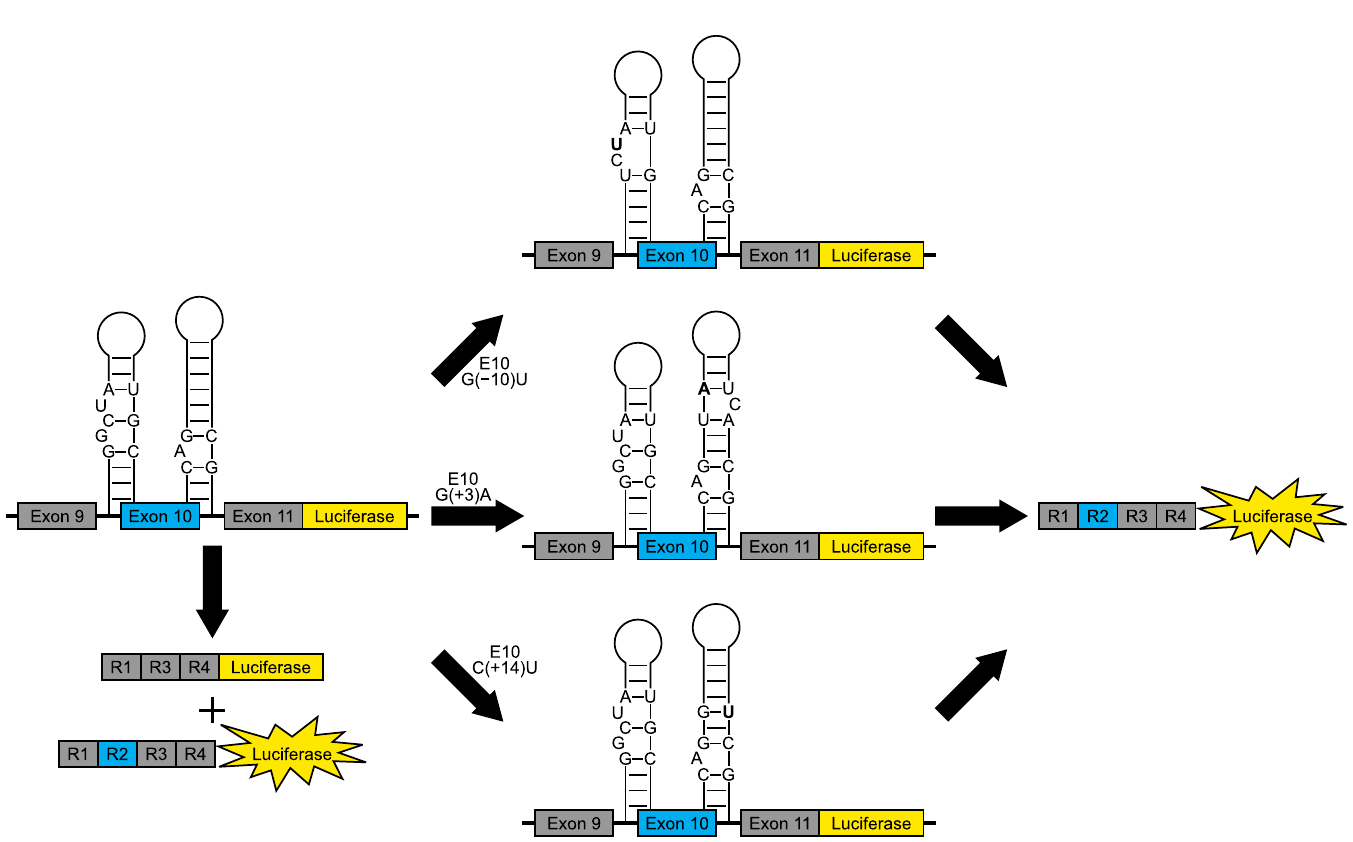
Fig 1. Schematic representation of cell-based assays with mini-genes expressing wild type tau or tau with mutations in intron 9 or 10. [34,36] Mini-genes contain exon 10 in frame with a firefly luciferase reporter gene. Wild type mini-genes express tau in a 4R-to-3R ratio of ~1. Mutations in this study (indicated in bold) that affect structures at splice sites adjacent to exon 10 lead to increased exon 10 inclusion and consequently, increased luciferase